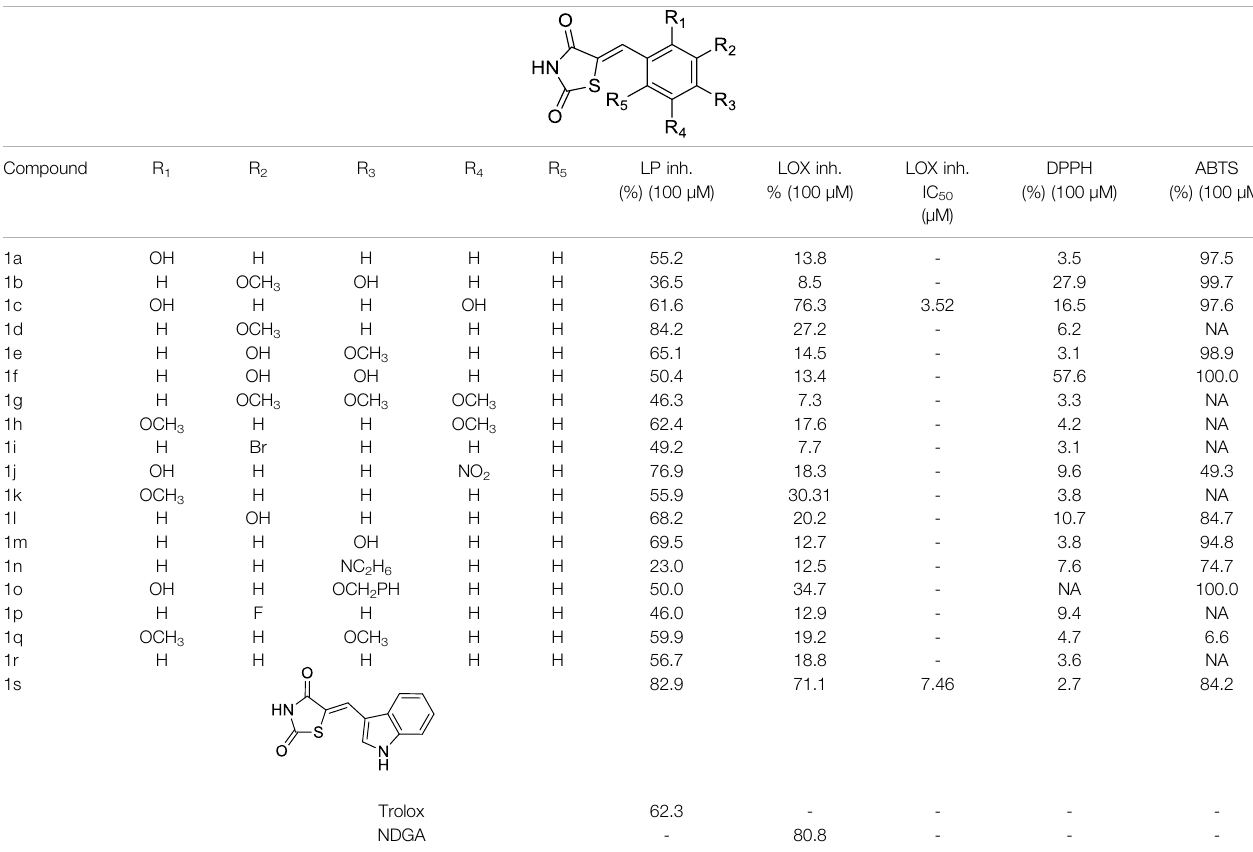
TABLE 4 | Structures of analyzed compounds, values of the experimentally determined inhibition of soybean lipoxygenase, the inhibition of lipid peroxidation induced by AAPH, DPPH, and radical scavenging ability (at 100 μ M concentrations of the compounds).